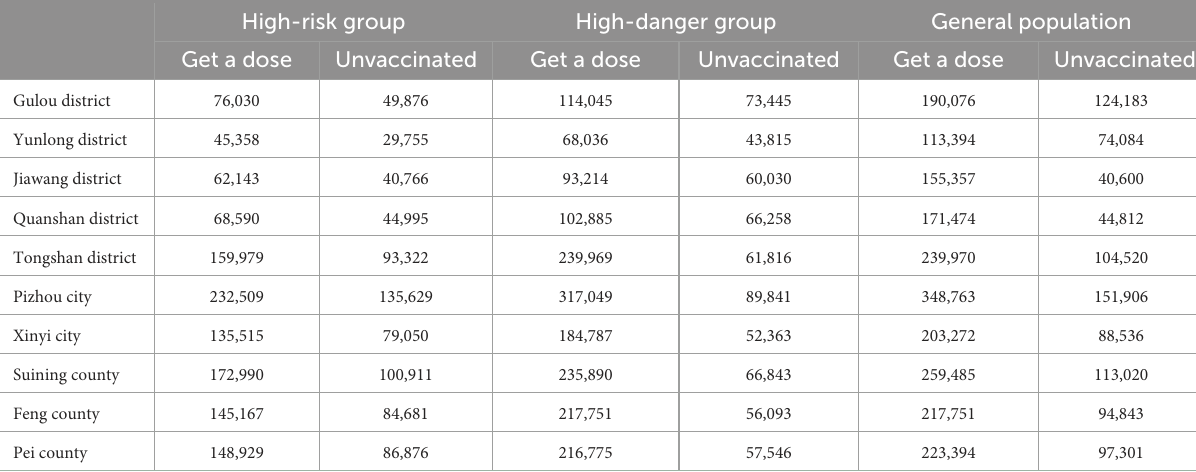
TABLE 8 Number of vaccinated individuals in each region. High-risk group General